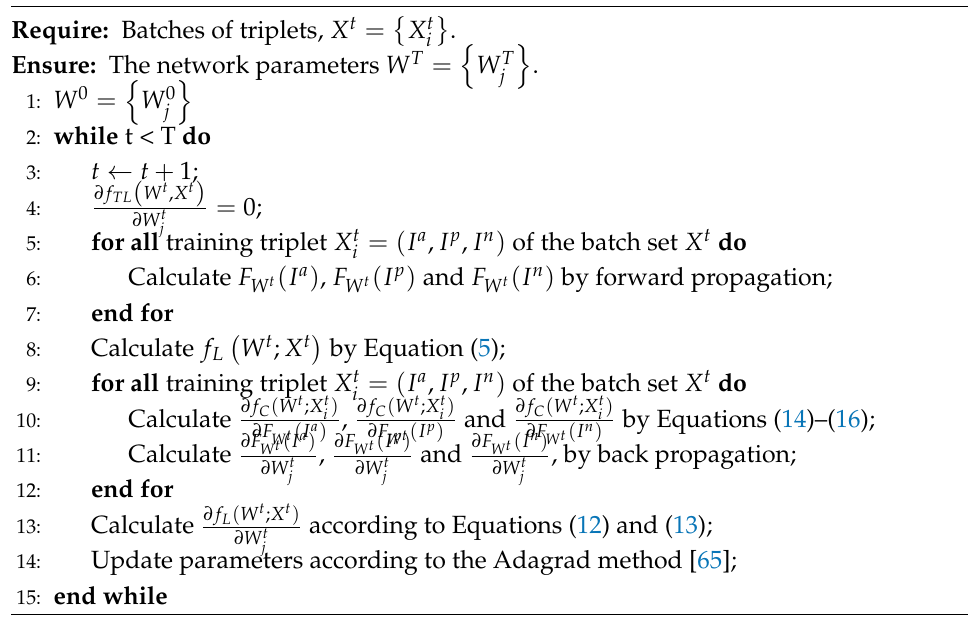
Algorithm 2 Triplet-based Mini-Batch Gradient Descent Learning Algorithm